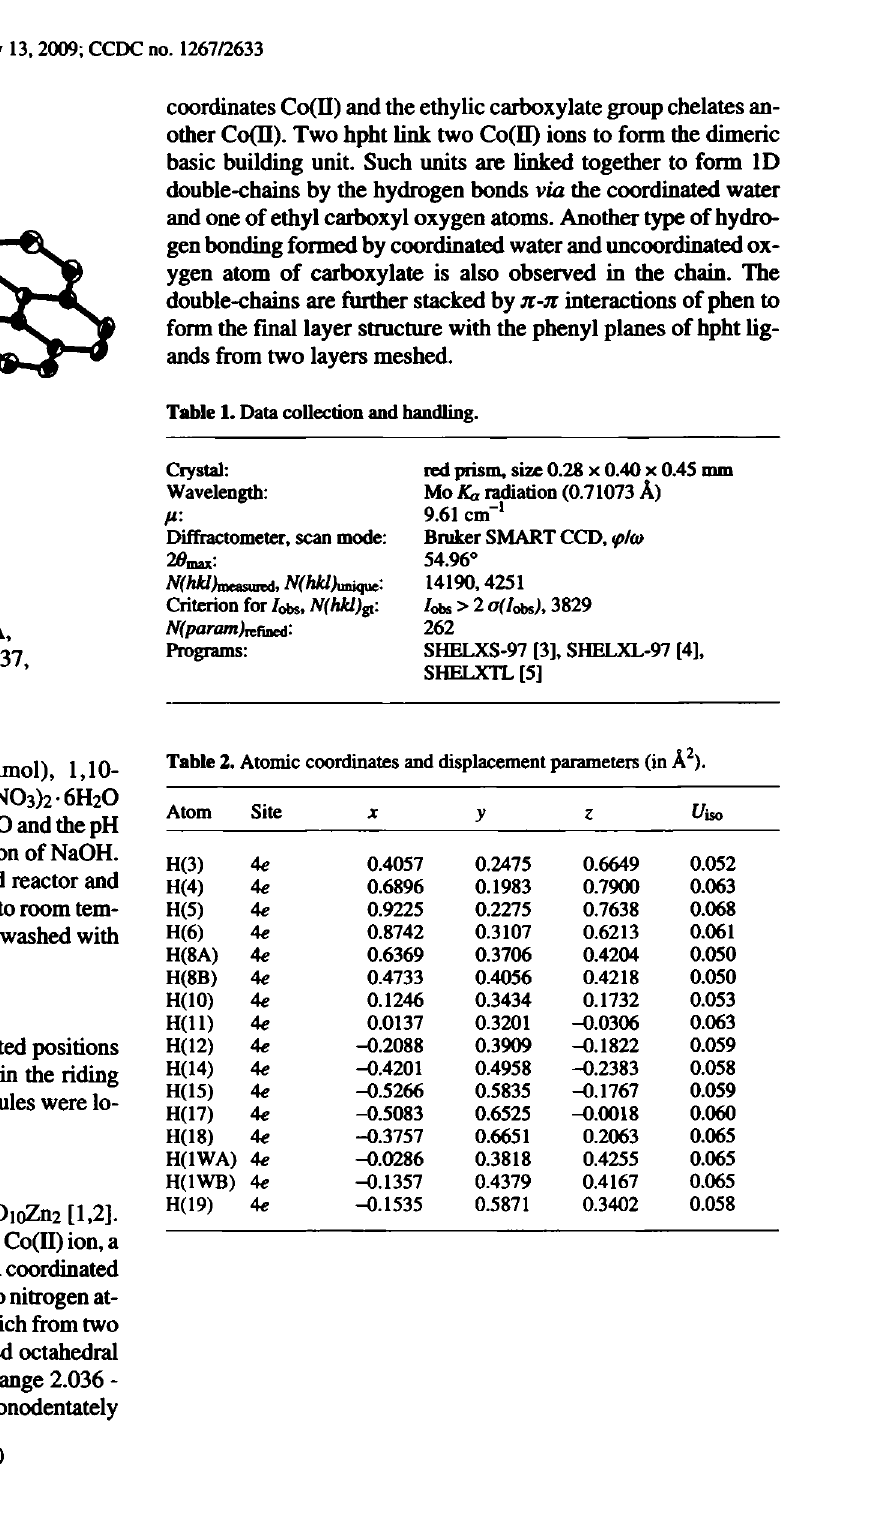
Table 1. Data collection and handling. Crystal: